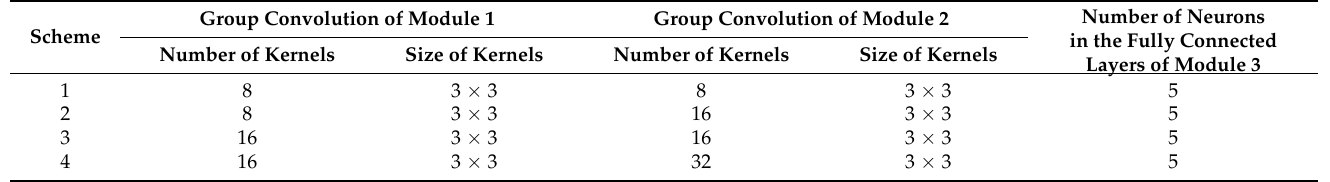
Table 3. Hyperparameter combination schemes with different number of convolution kernels 1 .